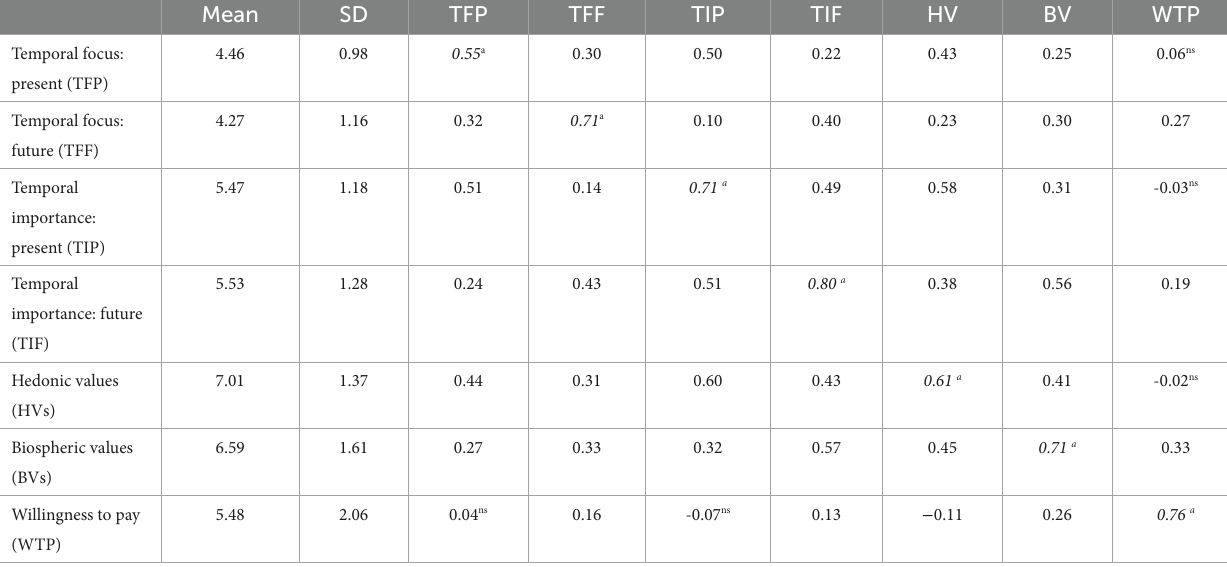
TABLE 3 Comparing the predictive validity of the TFS and the TIS for willingness to pay (WTP) in the time perspective behavioral model (TPBM). Constructs